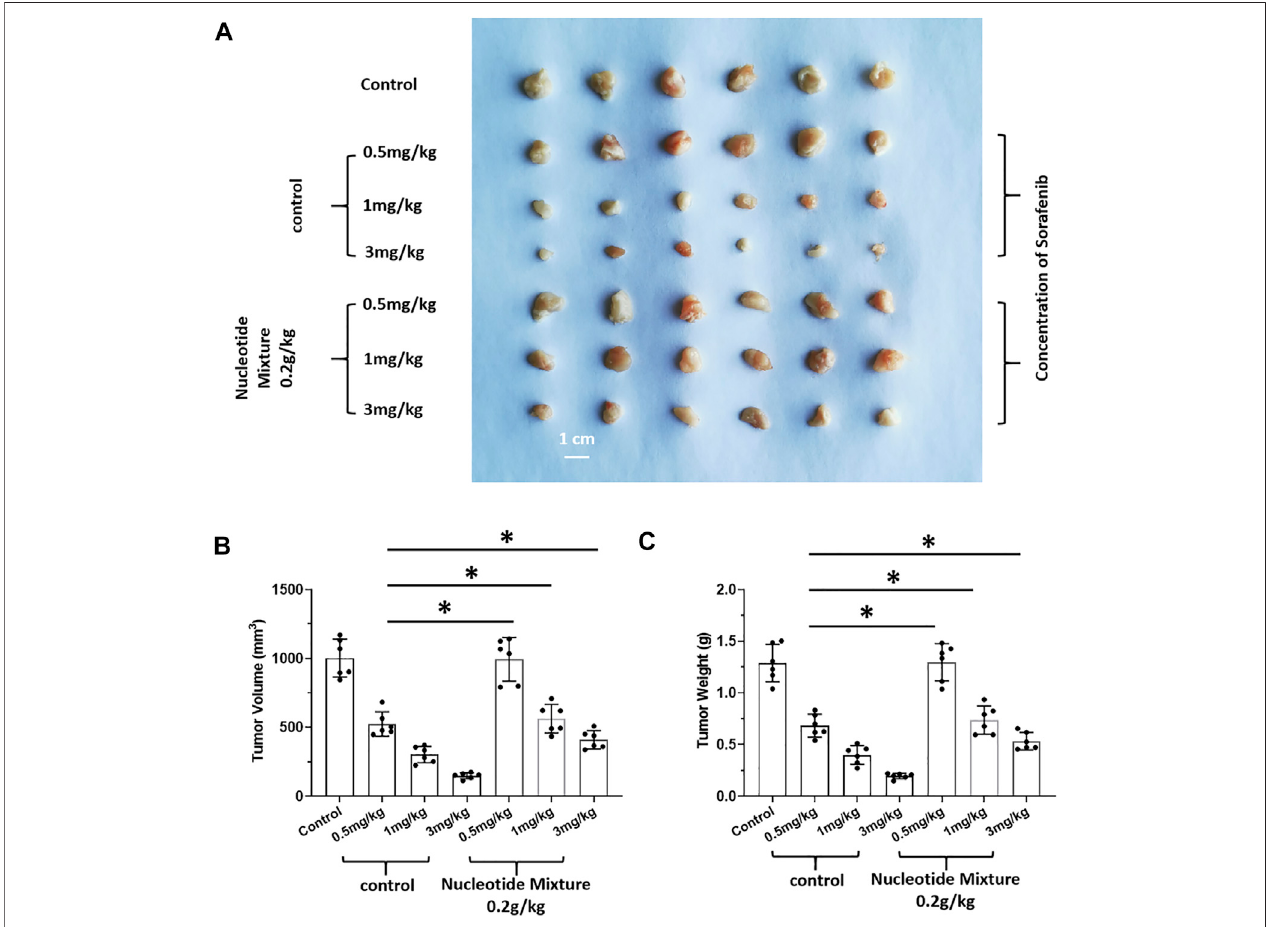
FIGURE 8 | Effect of the SNM on molecular-targeted drugs inhibiting the subcutaneous growth of human HCC cells in immunode fi cient mice. MHCC97-H cells were obtained by culture, and inoculated subcutaneously in immunode fi cient SCID mice. Then, mice were given sorafenib (0.5, 1, 3 mg/kg) alone or combined with the SNM (0.2 g/kg). Photographs of subcutaneous tumors (A) , tumor volume (B) , or tumor weight (C) are shown. * p < 0.05.